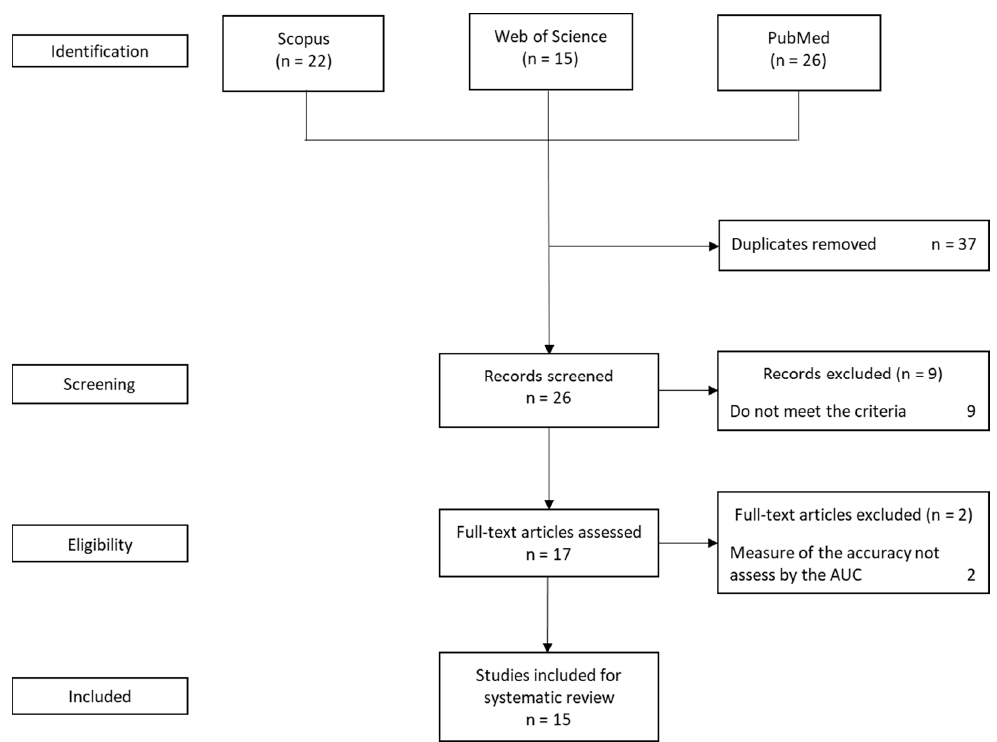
Figure 1. Flow diagram for study selection. Table 1. The studies selected for the systematic review.